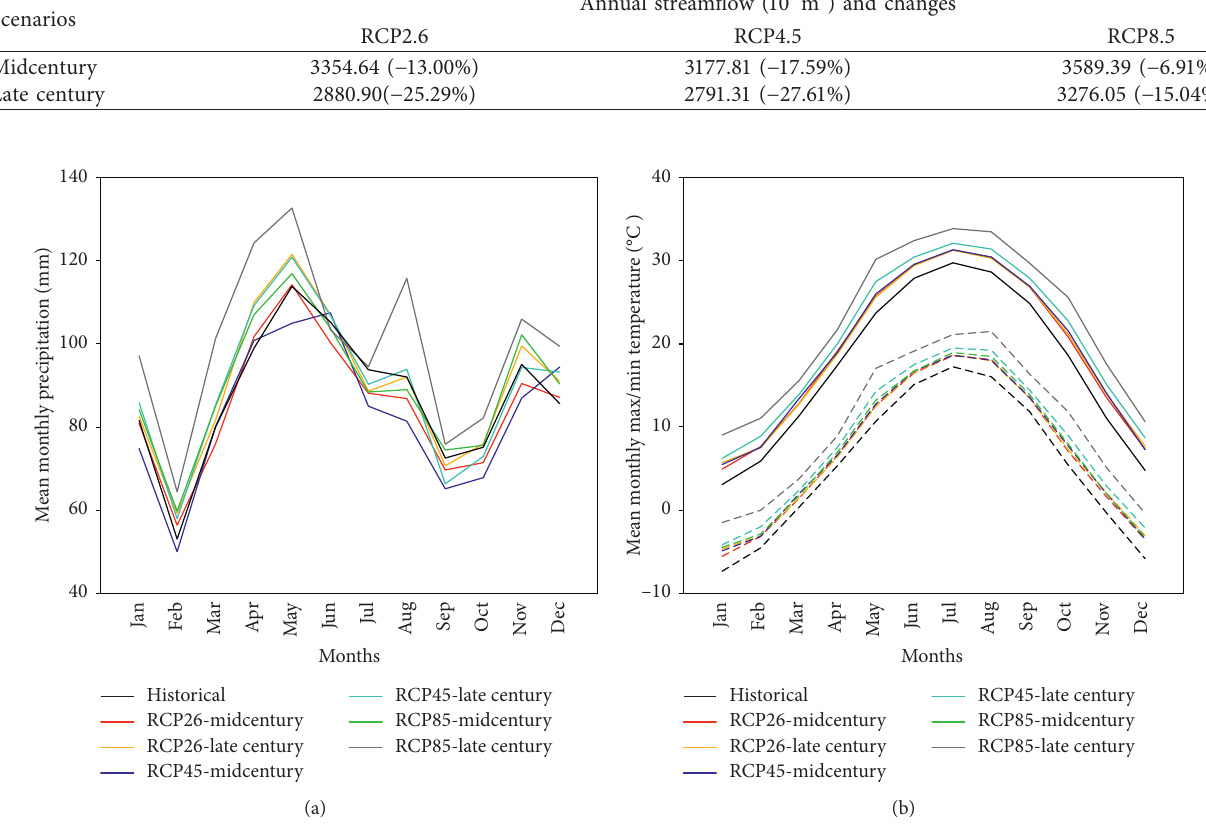
Figure 9: Annual cycle of mean monthly (a) precipitation and (b) maximum (solid lines) and minimum (dashed lines) temperatures averaged over the Wabash River Watershed for observation and multimodel ensembles for the historical period, midcentury, and late century under RCP